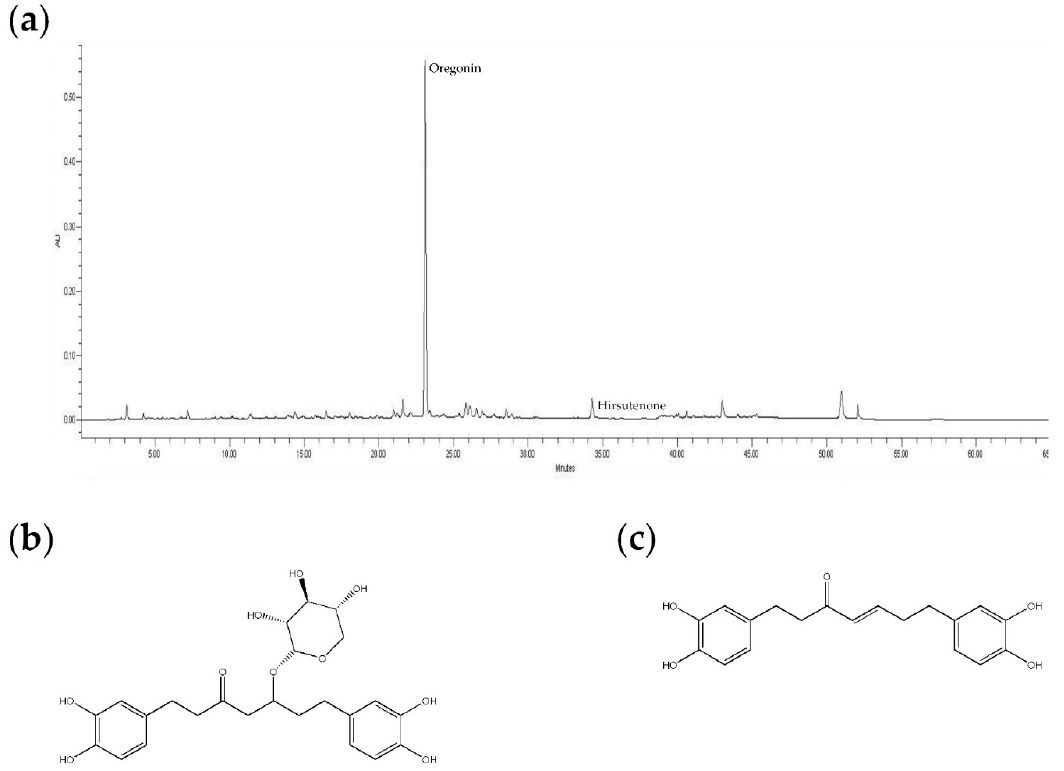
Figure 1. HPLC pattern of Alnus sibirica (AS) and major compounds in AS extracts: ( a ) HPLC pattern of AS; ( b ) The chemical structure of oregonin; ( c ) The chemical structure of hirsutenone (1,7-bis-(3,4- dihydroxyphenyl)-4-heptene-2-one).